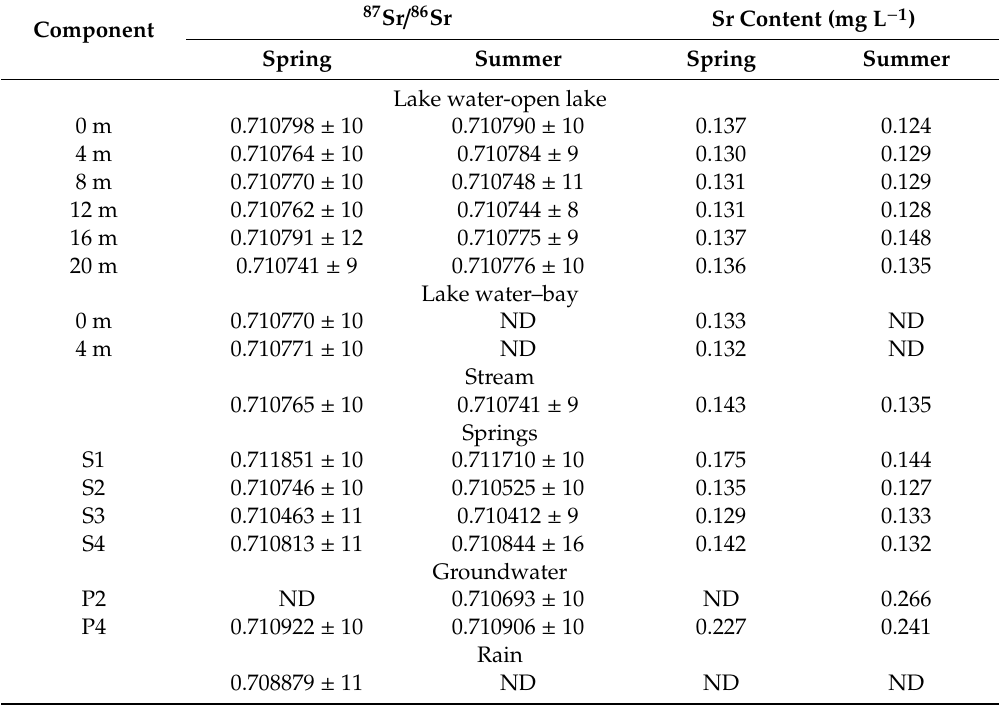
Figure 7. Depth profiles for ( a ) 87 Sr / 86 Sr and ( b ) Sr content of the lake water. Data for the springs, the stream, and the groundwater is also shown for comparison. Explanations for panel ( a ) also refer to panel ( b ). Table 4. Strontium isotope composition ( 87 Sr/ 86 Sr) and Sr content of components of the Lubi ń skie Lake hydrologic system.